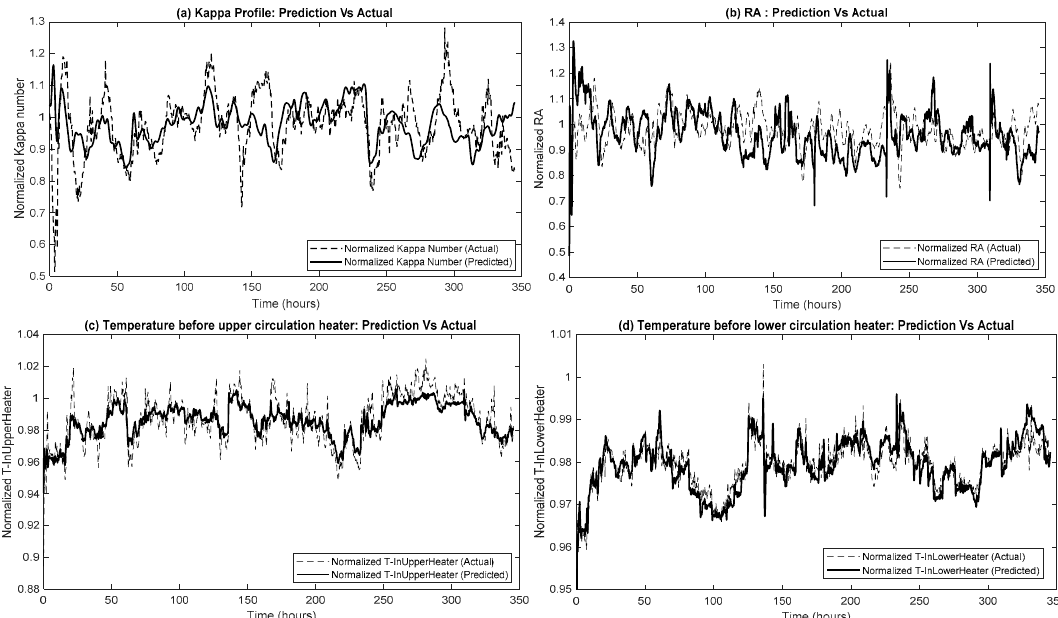
Figure 5. Comparison between actual and predicted. ( a ) Kappa number, ( b ) residual alkali (RA) of extraction fluid, ( c ) temperature before upper recirculation heat exchanger and ( d ) temperature before lower recirculation heat exchanger.